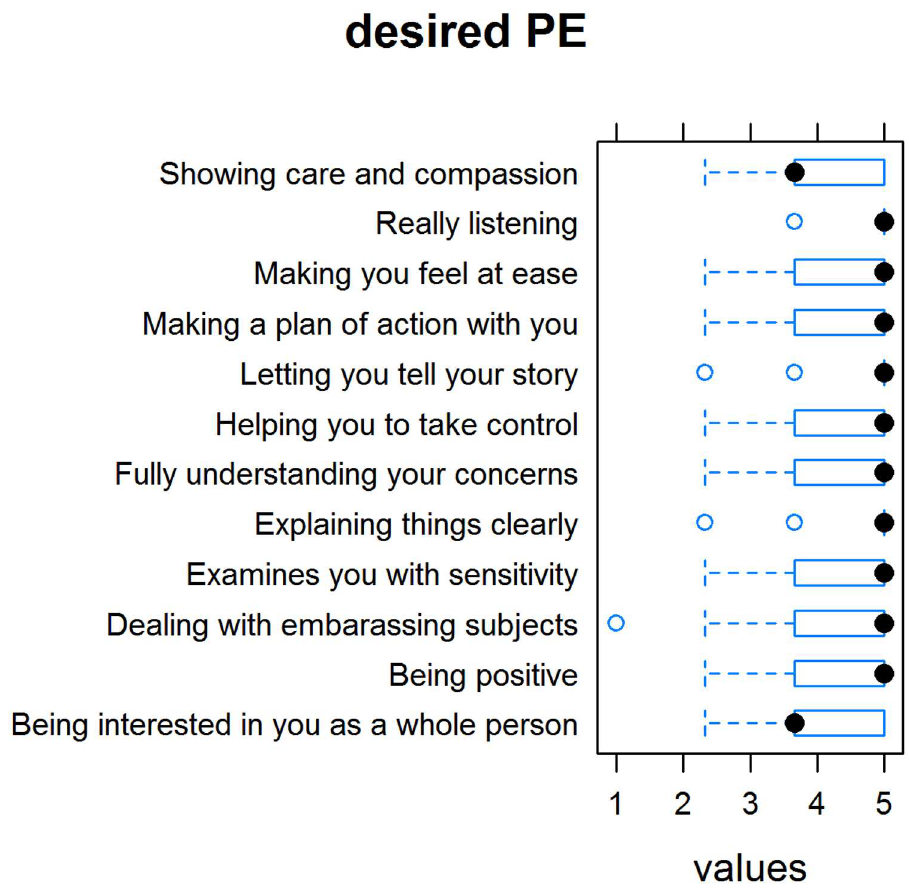
Fig 3. Rating of “desired empathy” items on the Consultation and Relational Empathy (CARE)